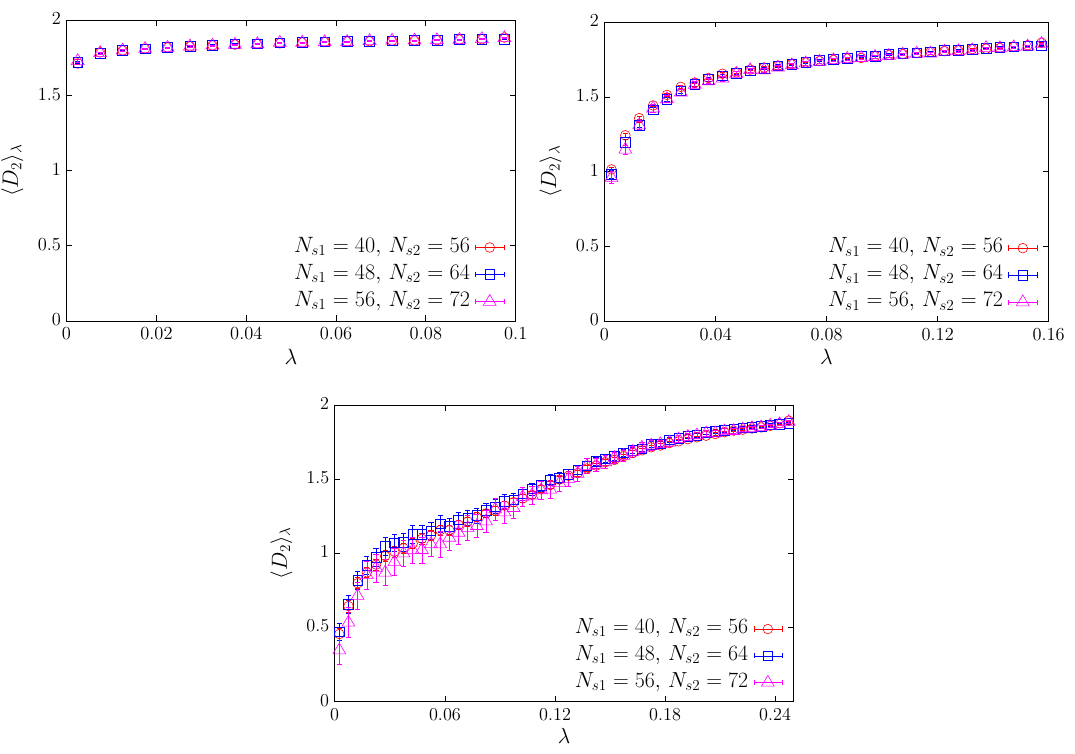
Figure 4 . Fractal dimension of the Dirac eigenmodes as a function of the spectral region in the confined phase, for ¯ β = 2 . 50 (top left), ¯ β = 3 . 00 (top right), and ¯ β = 4 . 00